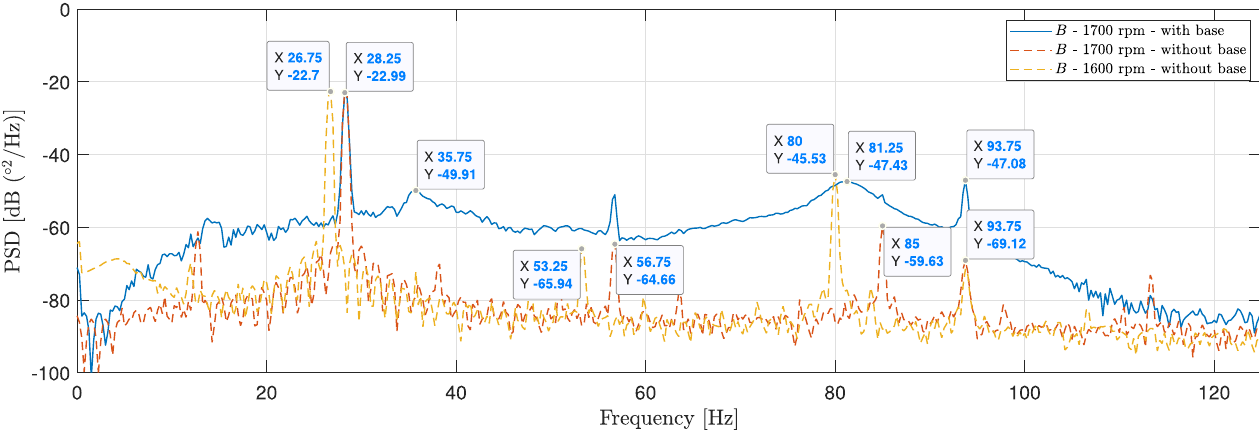
Fig. 11. Experimental comparison of angle B = β 27 − β 2 with and without base roll excitation in chirp